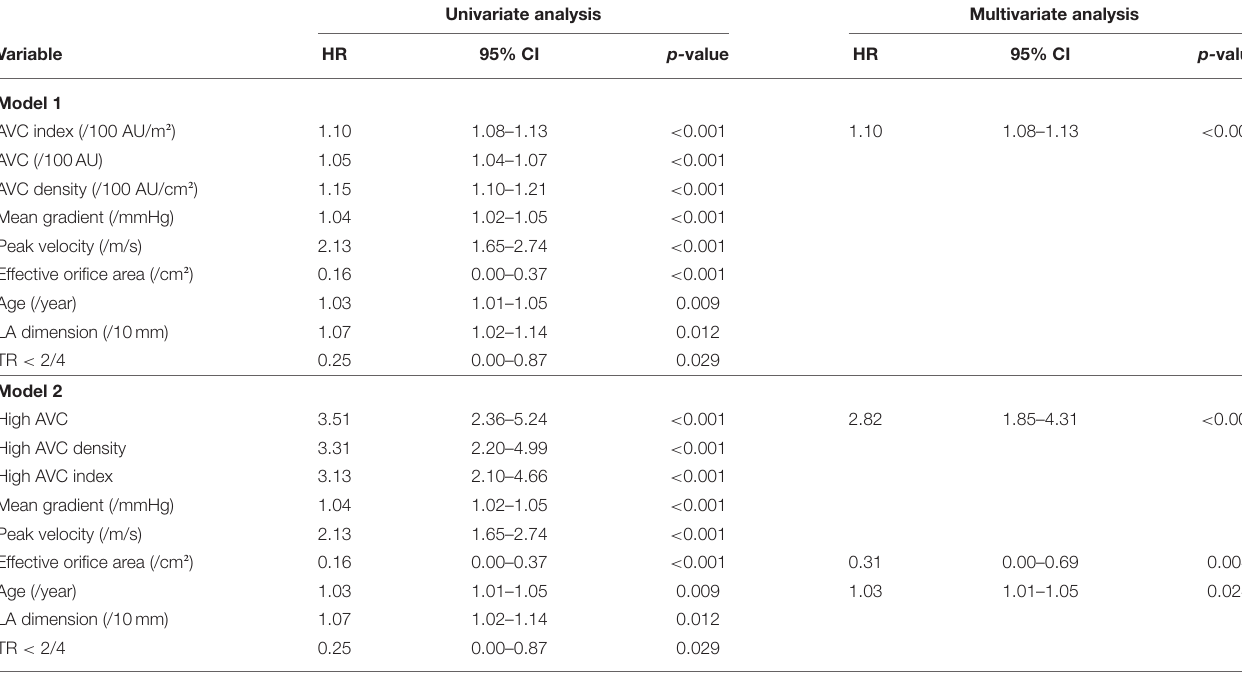
TABLE 5 | Cox’s proportional hazard analysis for the combined end-point of overall mortality and need for aortic valve replacement in the subgroup of 188 patients without a straightaway indication for AVR. Univariate analysis Multivariate analysis